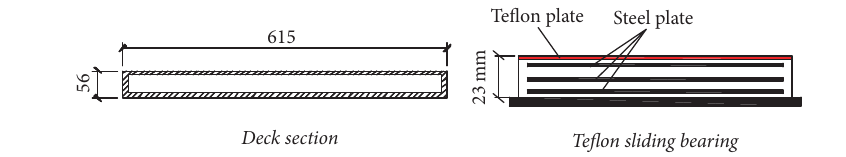
Figure 4: Details of the deck and sliding bearing design [mm].